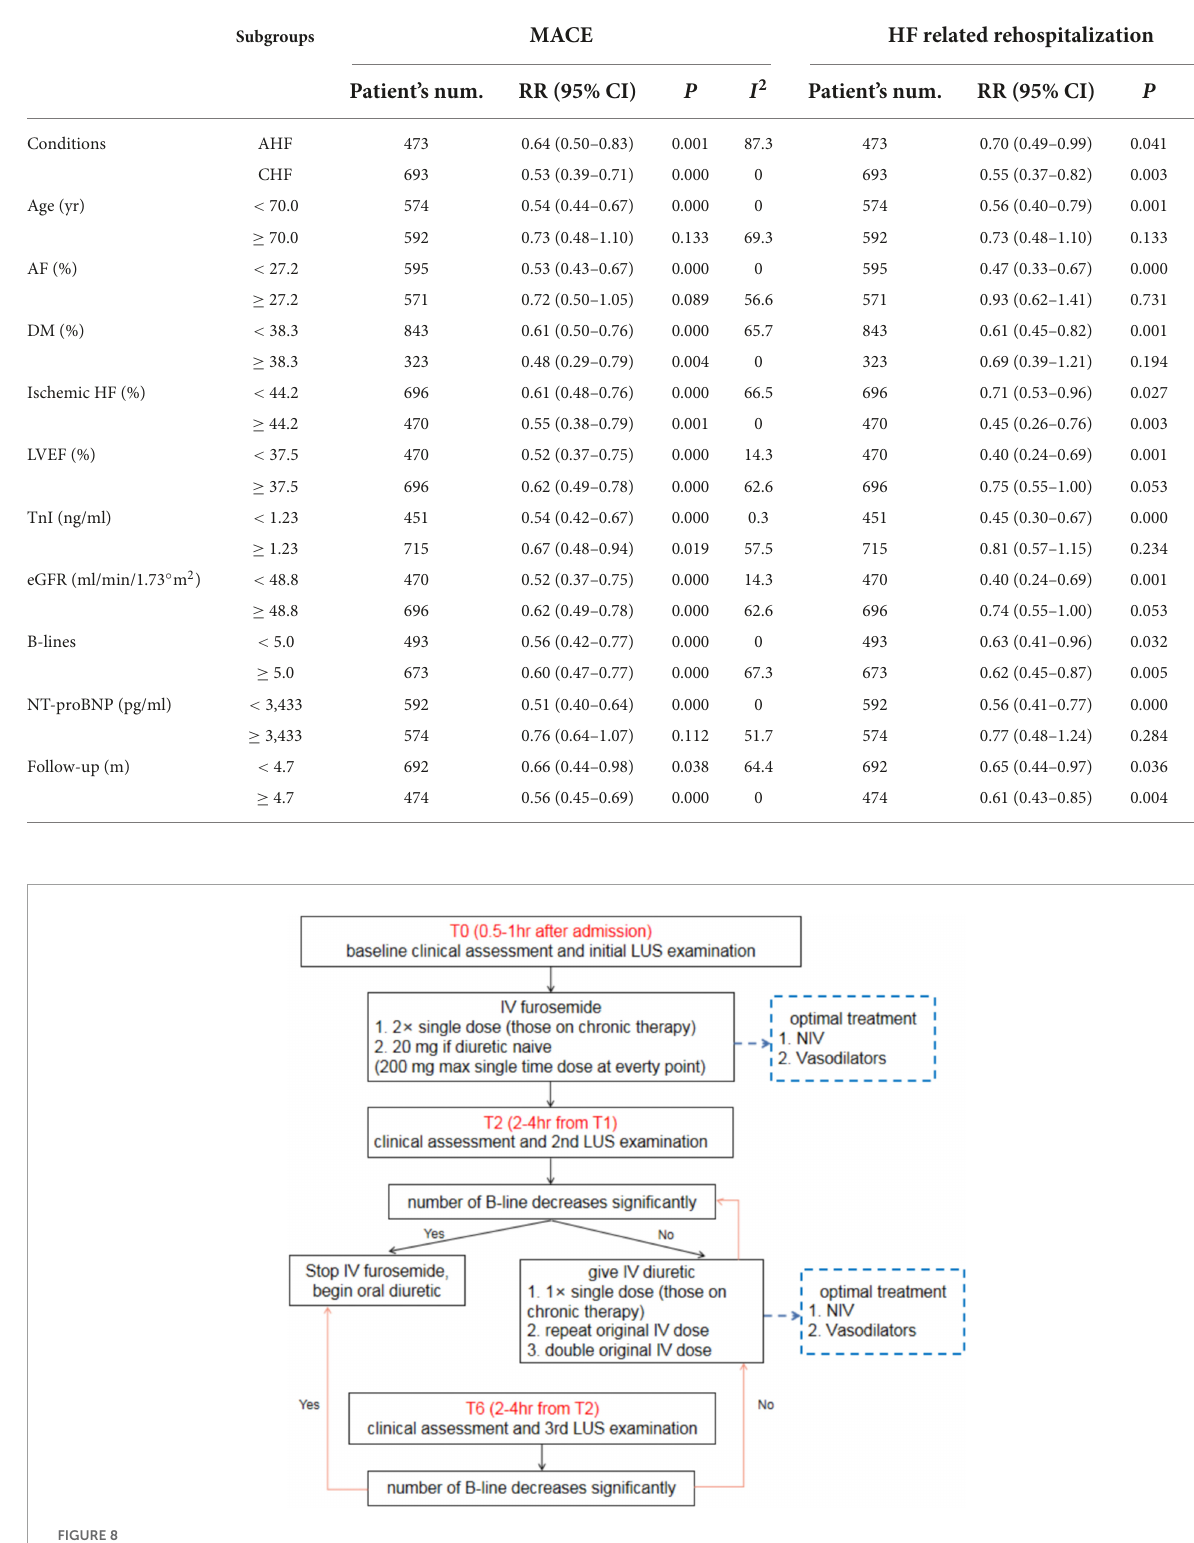
TABLE 5 Subgroup analyses.